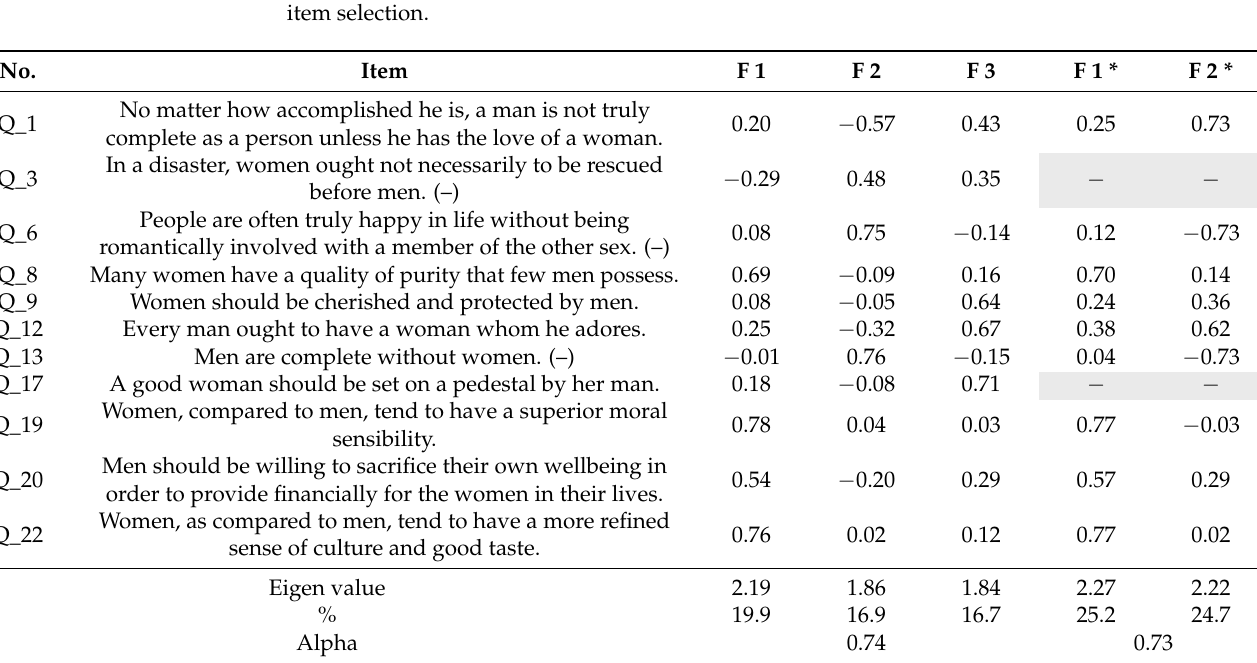
Table 2. Structural and metric characteristics of the Benevolent Sexism ( BS ) scale before and after item